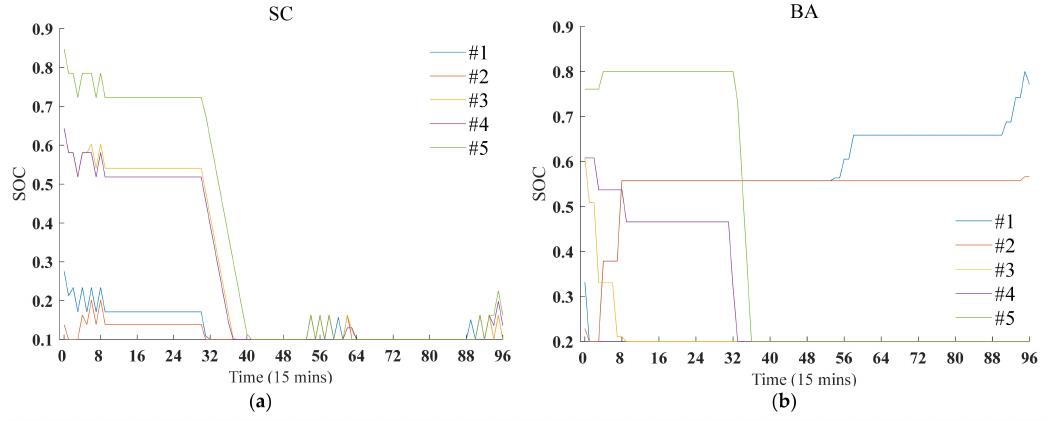
Figure 5. SOC curves of hybrid energy storage devices. ( a ) The supercapacitor pack; ( b ) The lithium battery